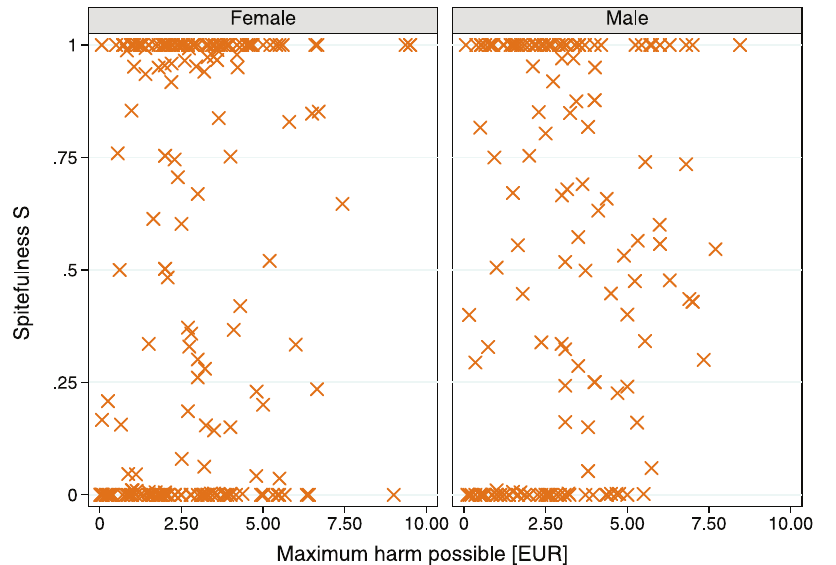
Figure 3. The effects of the magnitude of maximum harm possible and gender on spitefulness. The panels present the data separately for males and females. Each data point represents one observation of spitefulness relative to the magnitude of maximum harm possible.